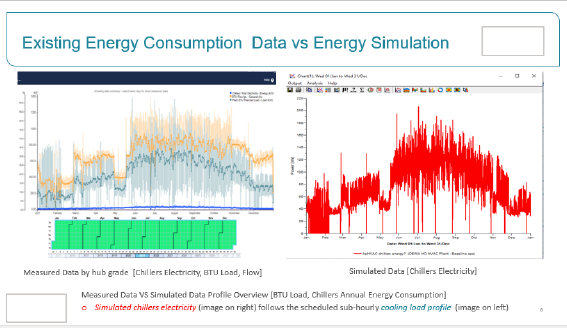
Figure 1: Existing data consumption vs Energy simulation The comparison between current and simulated energy consumption shows the opportunity to implement energy-saving measures and optimise energy consumption by around 2.8% electricity savings, as in Figure 2.